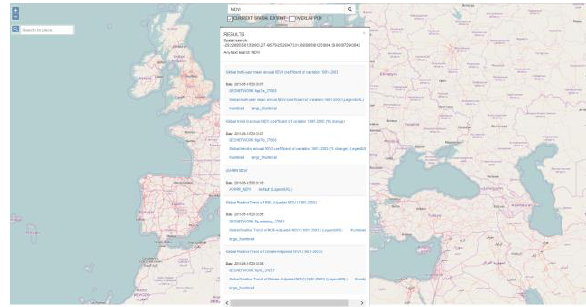
Figure 9. GUI of Bolegweb Geospatial Portal of OGC Resources – sample user query searching for “NDVI” data overlapping spatially overlapping the bounding box defined by the map window